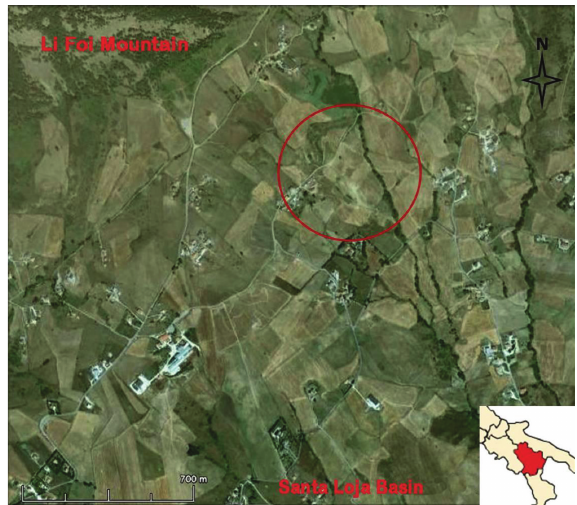
Figure 1: Study area location (from Google Earth, modified).